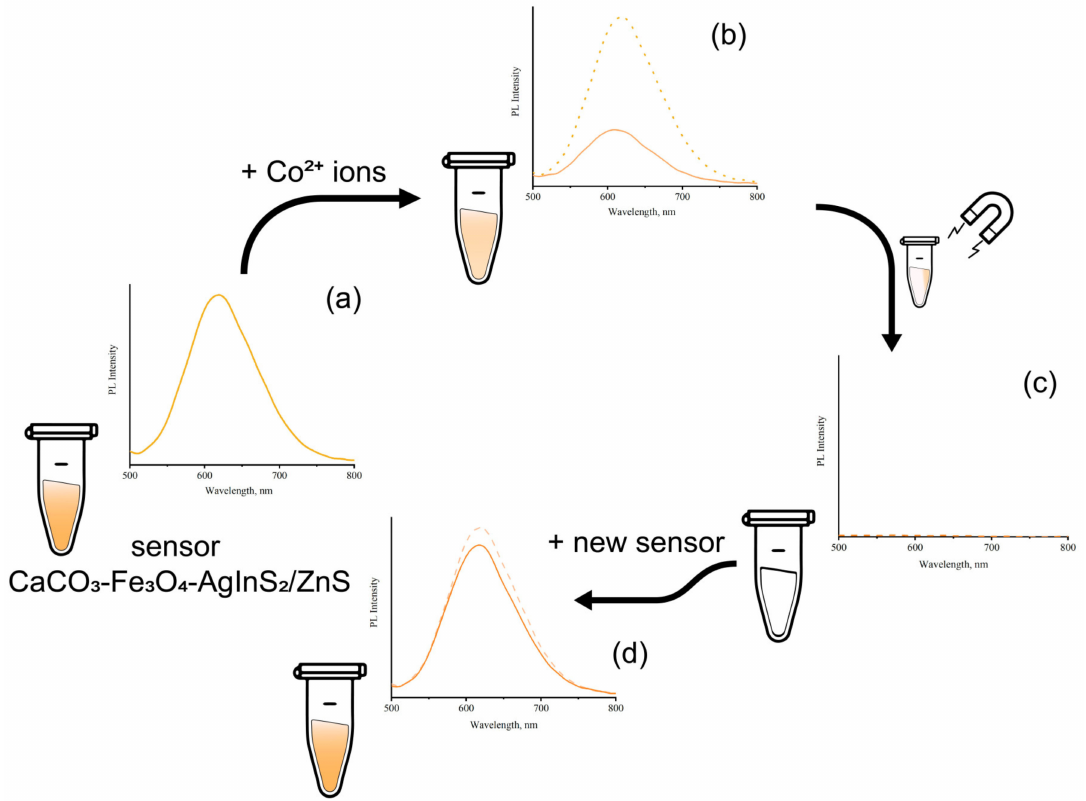
Figure 4. ( a ) PL spectra of the CFA fluorescent sensor without heavy metal ions, ( b ) PL spectra of the CFA fluorescent sensor with Co2 + ions in comparison with a solution without the presence of heavy metal ions (dashed line), ( c ) PL spectra of the solution after removing the CFA fluorescent sensor, ( d ) PL spectra of the solution after adding a new portion of CFA sensor in comparison with a solution without the presence of heavy metal ions (dashed